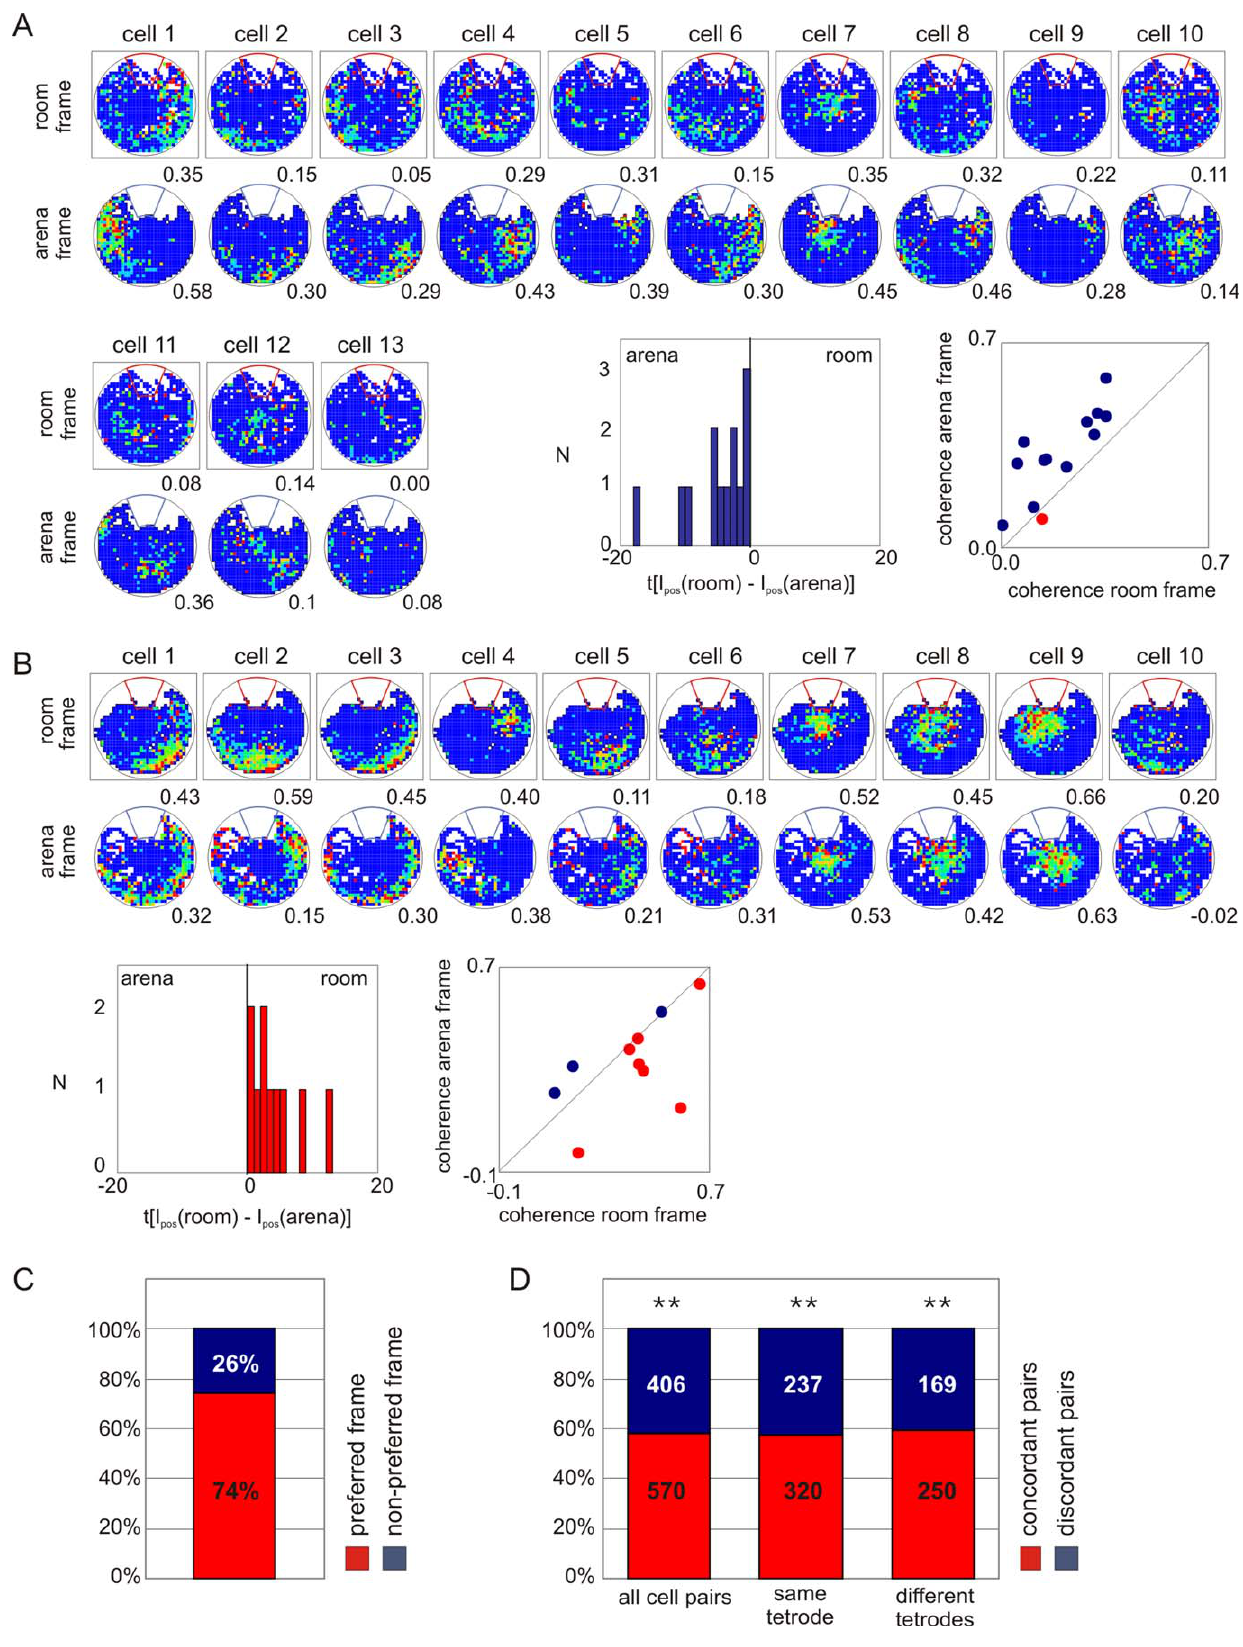
Figure 3. The ensemble preference for one spatial frame dominates two-frame avoidance sessions. An example of an arena-preferring (A) and a room-preferring (B) ensemble. The difference between room frame and arena frame I pos for each cell indicates an arena preference in Ensemble A and a room preference in Ensemble B. Scatter plot of arena map coherence and room map coherence also indicates the ensemble frame